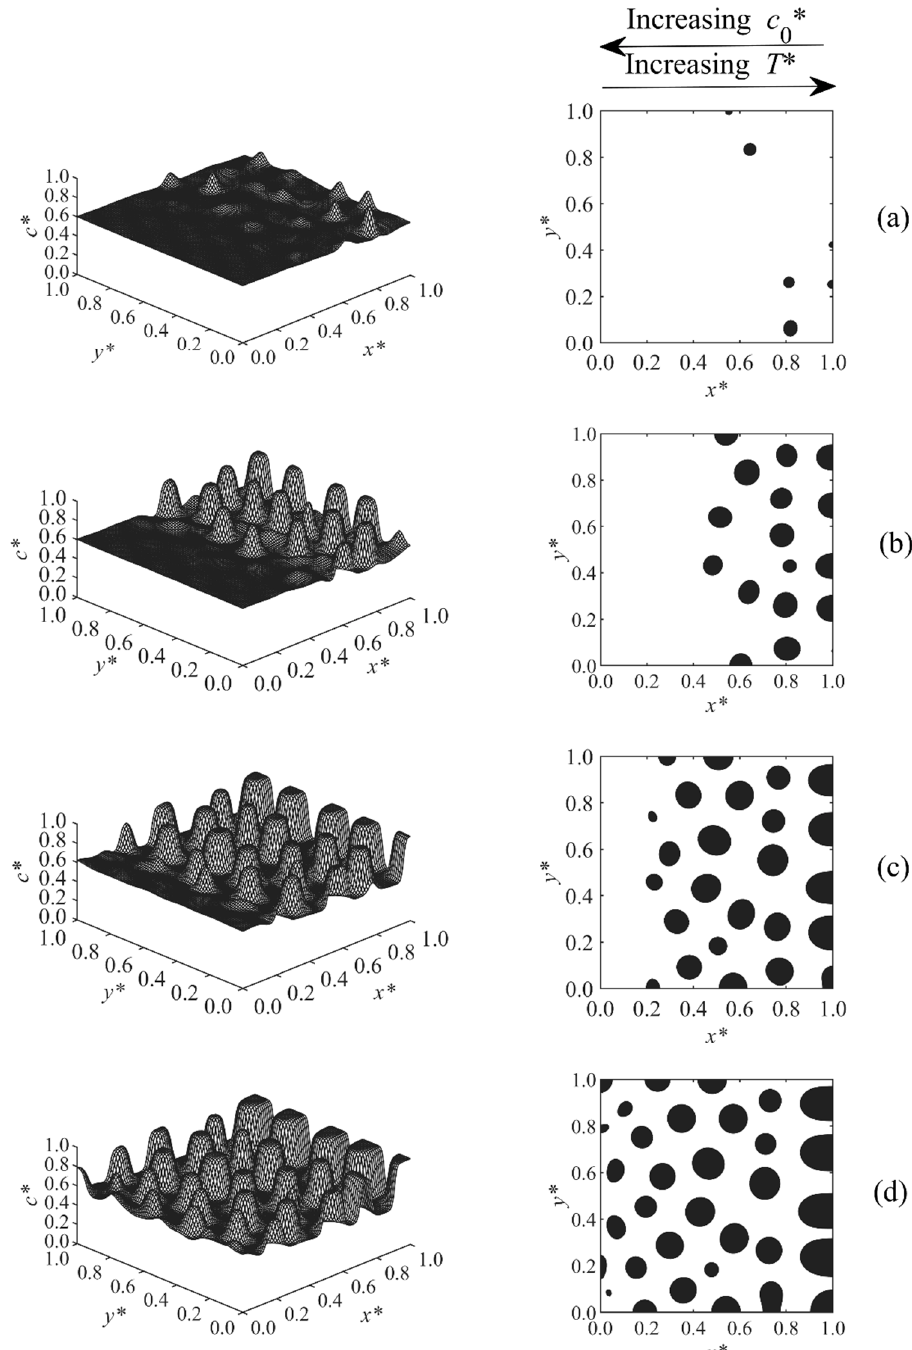
Figure 7. Spatial concentration profiles (first column) and phase-separated patterns (second column) for Case 6 at the following times: ( a ) t ∗ = 1.095 × 10 − 4 , ( b ) t ∗ = 1.1 × 10 − 4 , ( c ) t ∗ = 1.11 × 10 − 4 , and ( d ) t ∗ = 1.12 × 10 − 4 .